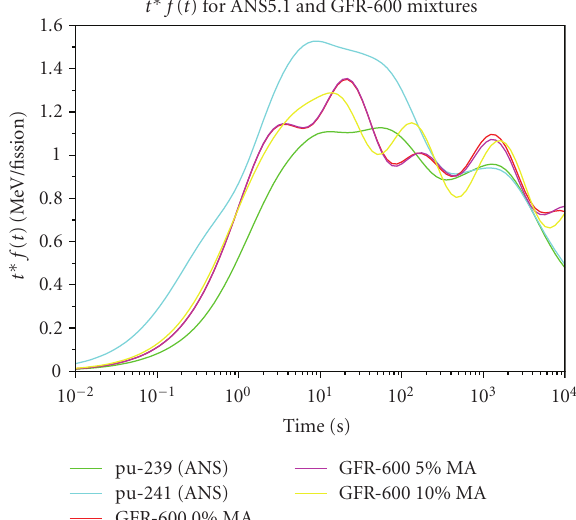
Figure 9: Plot of t · f ( t ) for the two plutonium isotopes in the ANS5.1 standard and for the 3 GFR-600 mixtures.